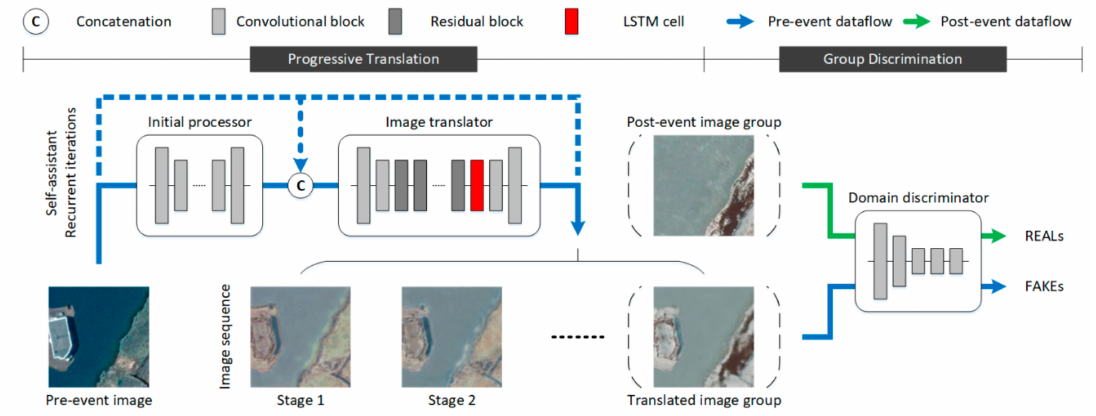
Figure 2. Framework of our proposed progressive domain adaptation method for change detection using season-varying remote sensing images.